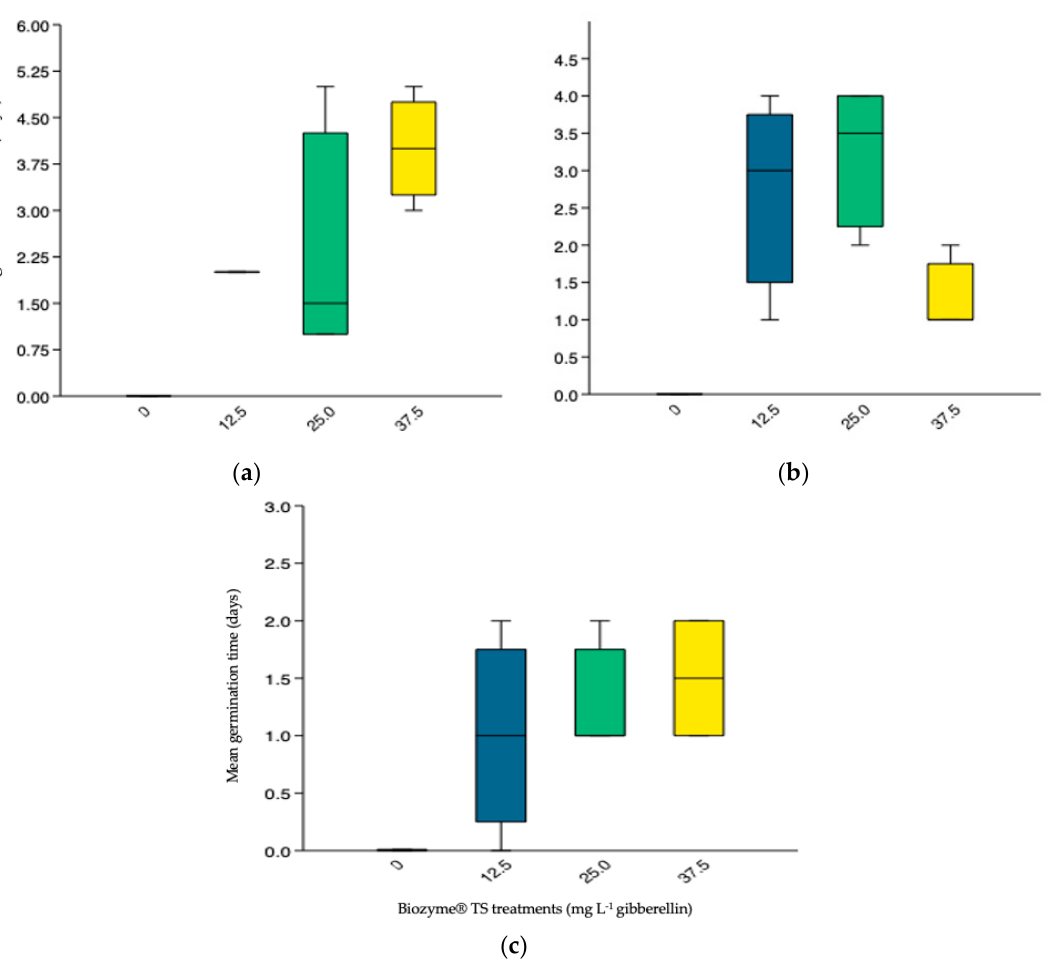
Figure 6. Response of mean germination time (MGT) to Biozyme ® TS (gibberellins), with: ( a ) 24 h, ( b ) 48 h, and ( c ) 72 h of immersion. Table 4. Comparison of means of mean germination time (MGT) with 24, 48, and 72 h of immersion in Biozyme ® TS (gibberellins), according to Tukey HSD.